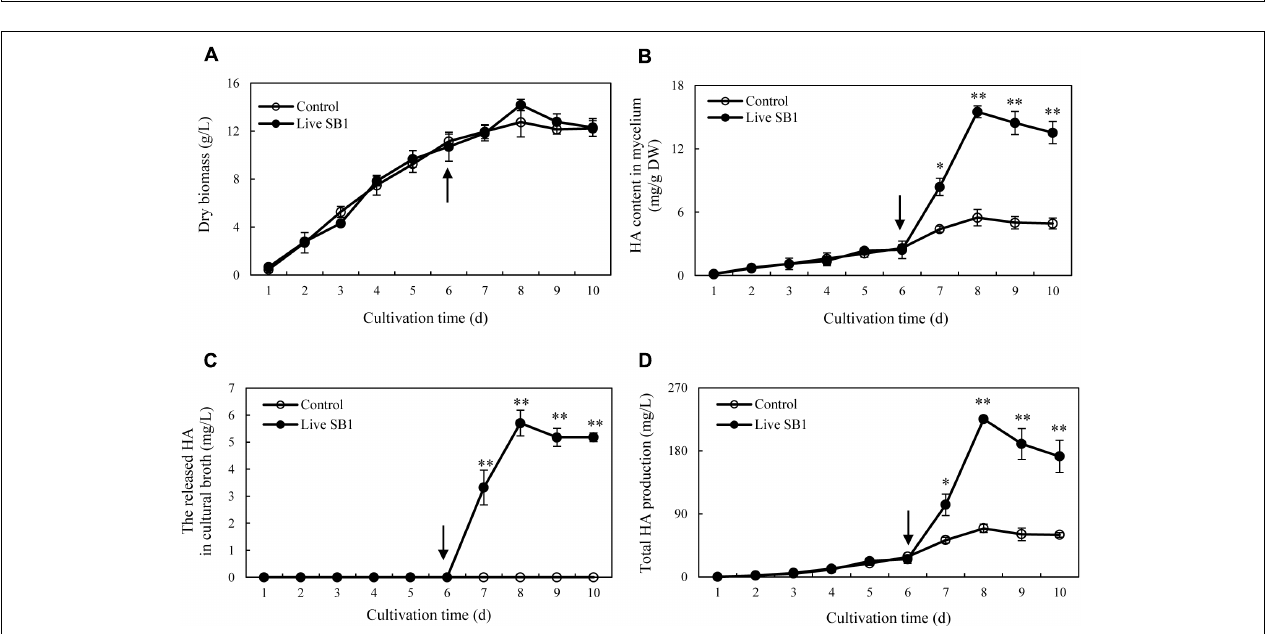
FIGURE 10 | Time profiles of mycelium dry biomass (A) , HA content in mycelium (B) , the released HA in cultural broth (C) , and total HA production (D) in submerged culture of Shiraia sp. S9 with or without live SB1 treatment at 400 cells/ml on day 6. The culture was maintained in a 150-ml flask containing 50 ml of the liquid medium at 150 rpm and 28 ◦ C for 8 days. The arrow represents the time of addition of live SB1. Values are mean ± SD from three independent experiments. ∗ p < 0.05 and ∗∗ p < 0.01 versus